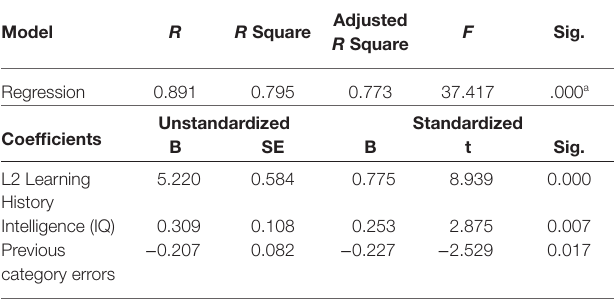
TABLE 6 | Results of multiple regression analyses on Chinese reading comprehension. Model